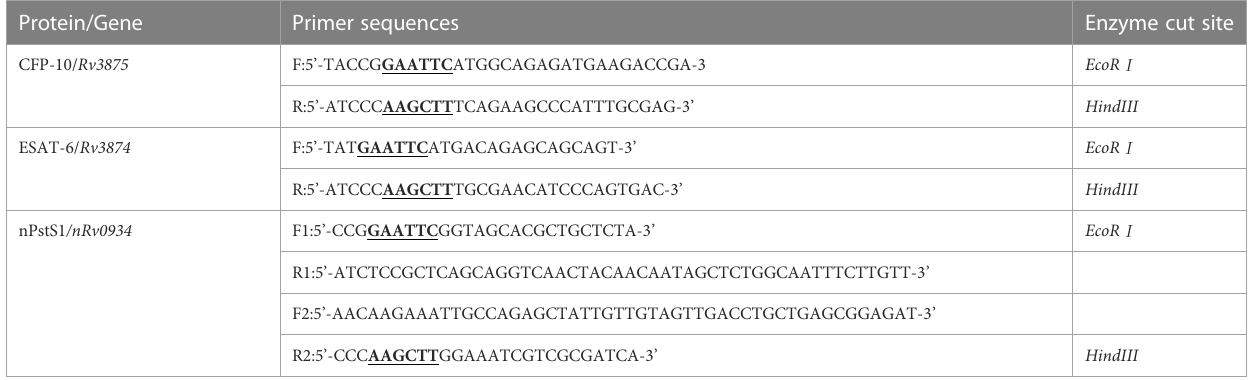
TABLE 2 The primer sequence table of ESAT-6 、 CFP-10 and nPstS1.